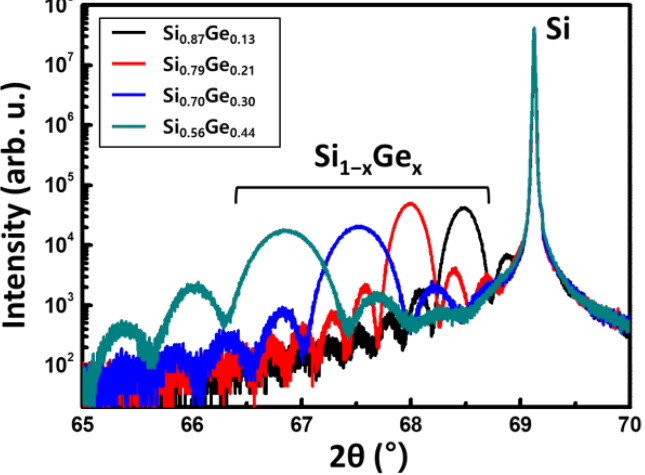
Figure 1. Schematic representation of vertical etching of ( a ) Si, ( b ) Si 1−x Ge x , and ( c ) lateral etching of Si in TMAH etchant.